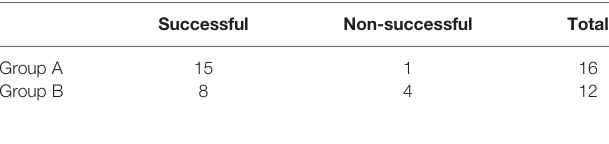
TABLE 5 | Primary results in Group A and B.